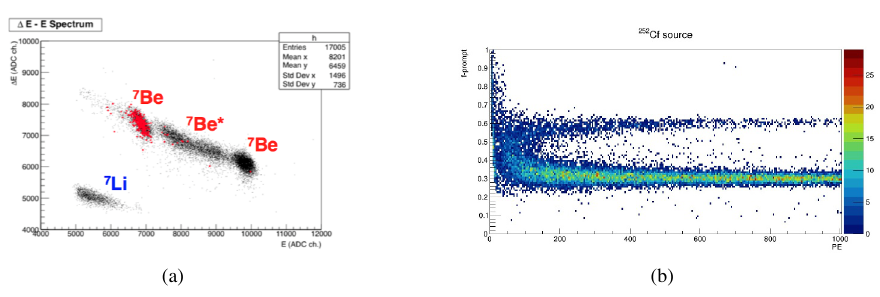
Figure 2. (a) Scatter plot of the amplitudes of the ∆ E and E Si detectors, placed at 5 deg with respect to the beam axis. The red markers are events having a coincident signal in the TPC. (b) The fraction of prompt light in the scintillation pulse (f-prompt) versus the total charge collected by the two SiPM arrays, expressed in units of photoelectrons (PE): are clearly visible the two di ff erent bands of neutrons (upper band) and γ -rays (lower band) that leave a signal inside the